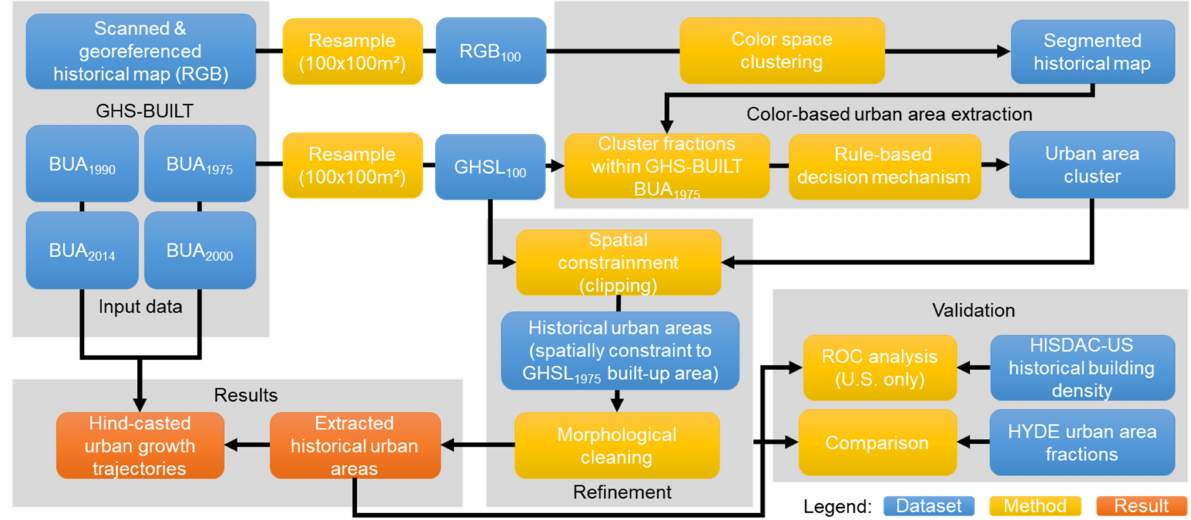
Figure 5. Flow diagram illustrating the historical urban area extraction and validation